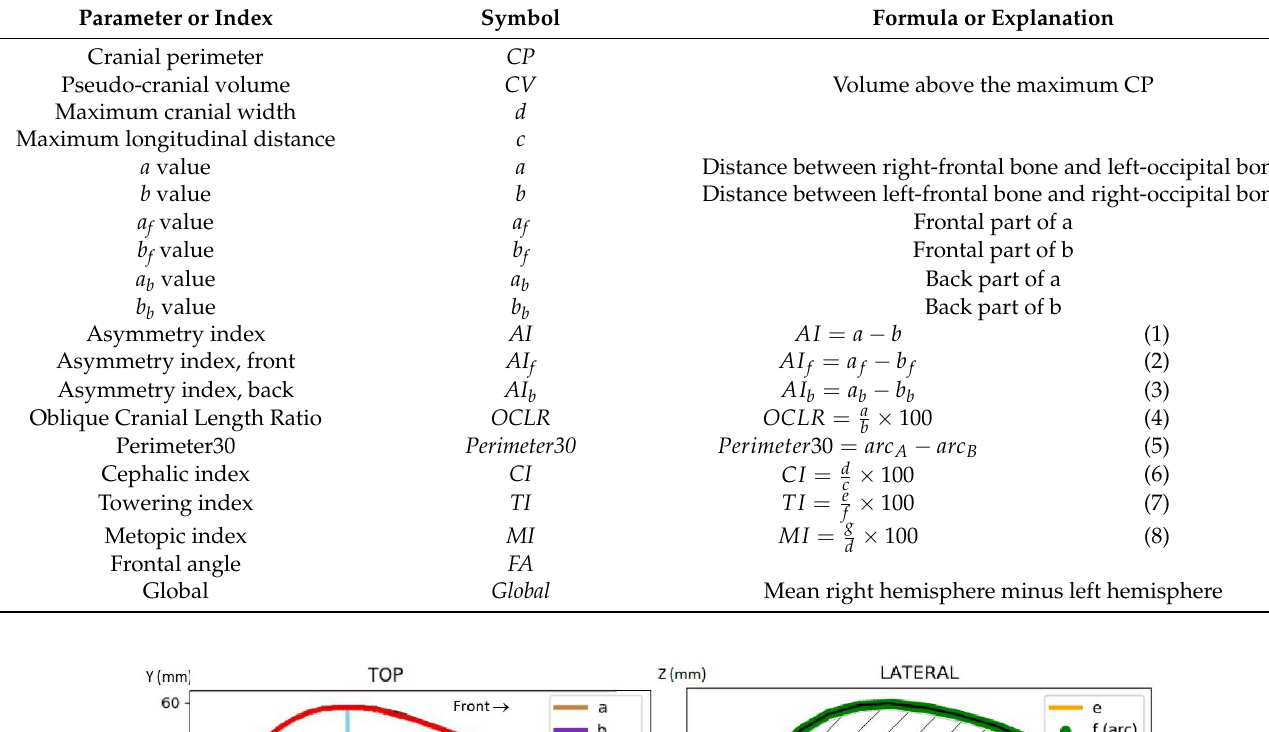
Table 1. Anthropometric parameters and cranial deformation indices.